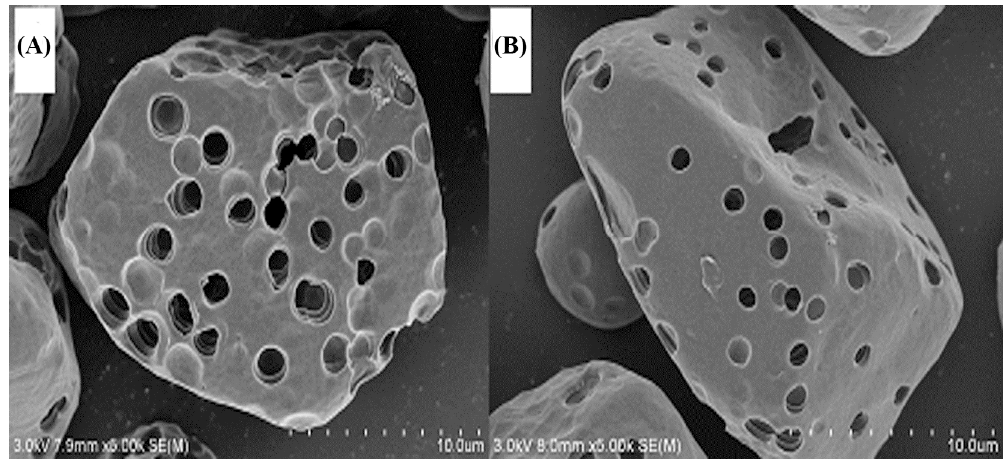
Figure 6. Scanning electron microscope (SEM) images of MPS before ( A ) and after ( B ) adsorption of TPS, magnified 5000 times.